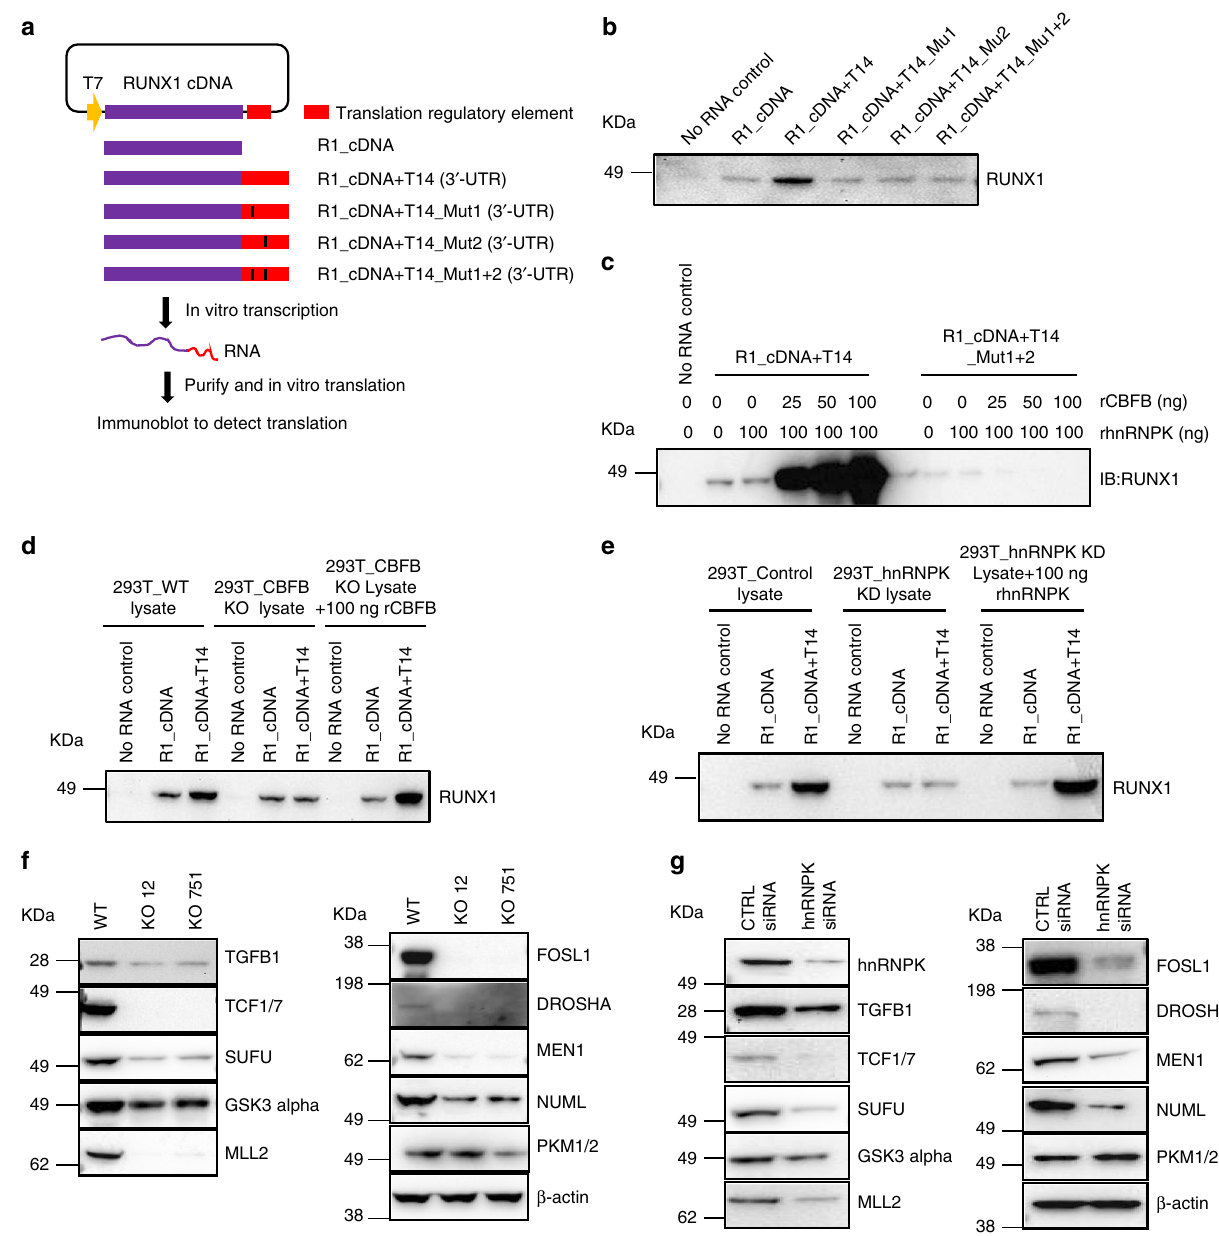
Fig. 4 CBFB and hnRNPK regulate translation. a Flow chart showing the in vitro translation assay to test the effect of a translation element (RNA) and a protein. In vitro transcribed RNA was used in the in vitro translation assays using HeLa cells lysate. b In vitro translation assay using the 1-Step Human coupled IVT kit showing the effect of CBFB and hnRNPK binding sites (T14) on RUNX1 translation. c In vitro translation assays using the 1-Step Human coupled IVT showing effect of recombinant CBFB (rCBFB) and hnRNPK (rhnRNPK) on RUNX1 translation. d In vitro translation assay using WT and CBFB_KO HEK 293 T cells lysate. See “ Methods ” section for details of preparation of 293 T cell lysate. e In vitro translation assay. Un-transfected (control) and hnRNPK knockdown (KD) HEK 293T cells lysate replaced the HeLa cell lysate in the 1-Step Human coupled IVT kit with or without the supplement of rhnRNPK. f IB showing the effect of CBFB deletion on the proteins encoded by bound transcripts. g IB showing the effect of hnRNPK KD on the proteins encoded by bound